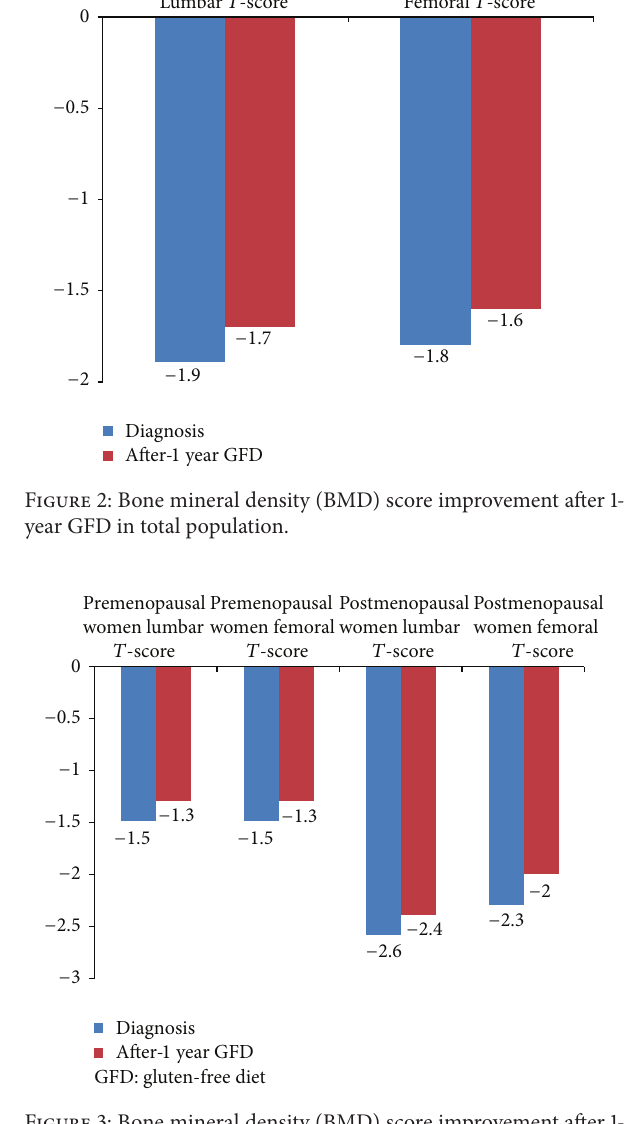
Figure 3: Bone mineral density (BMD) score improvement after 1- year GFD according to menopausal